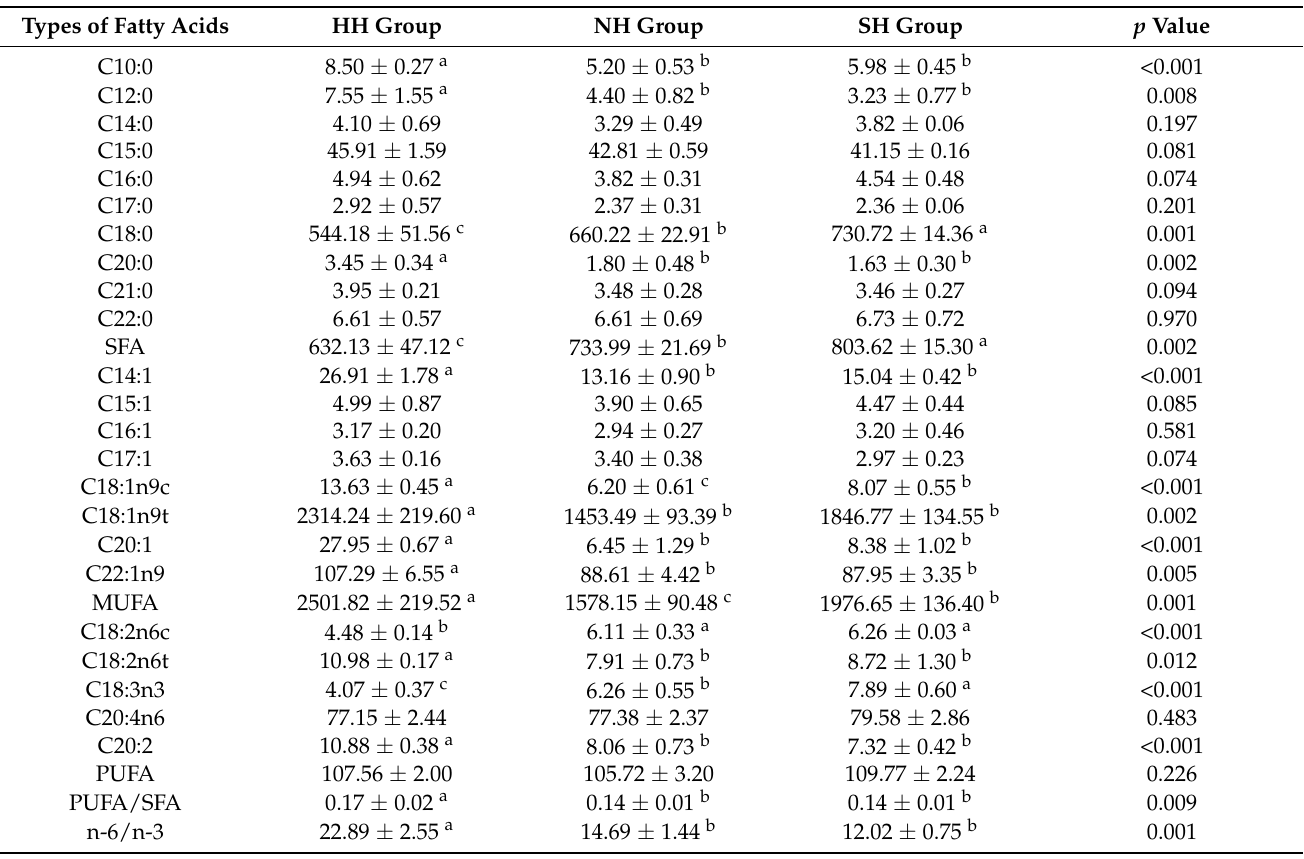
Table 1. Composition and content of fatty acids in F 1 crossbred